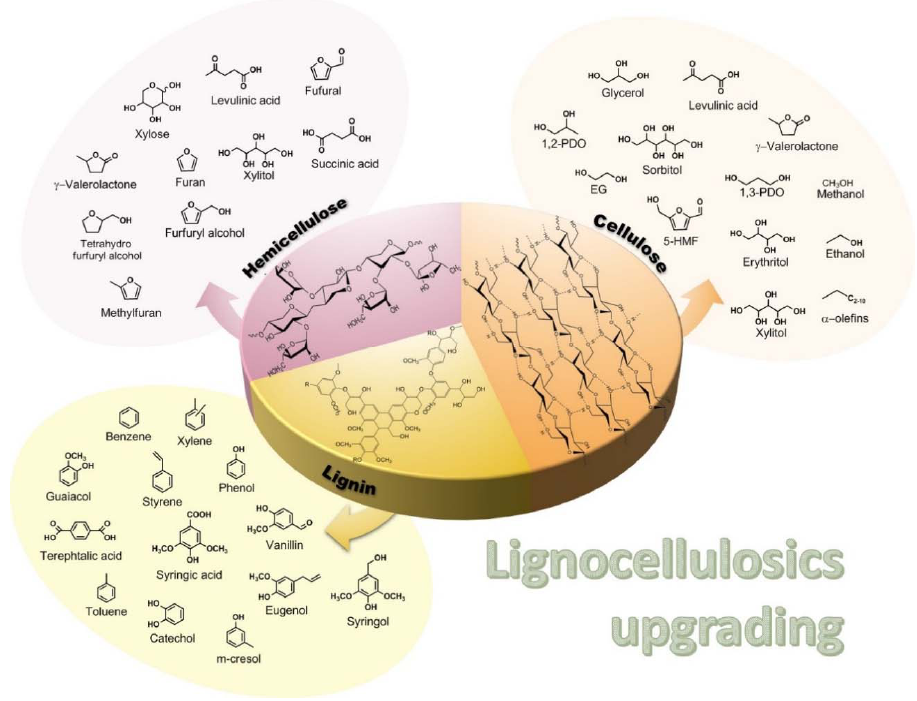
Figure 1. Chemical structure of cellulose, hemicellulose, lignin, and their relative derived molecules.